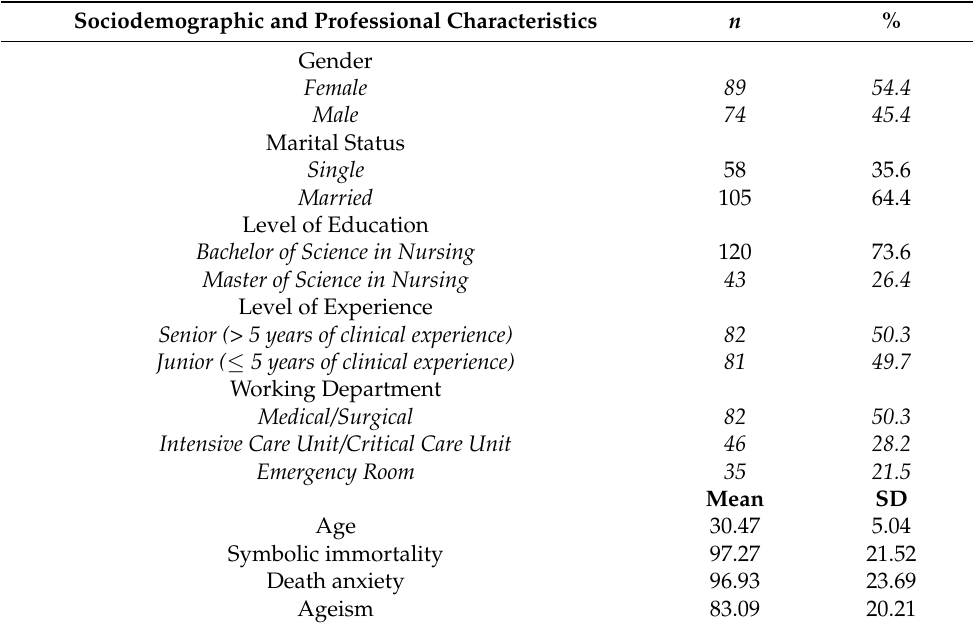
Table 1. Participant demographic characteristics ( n =